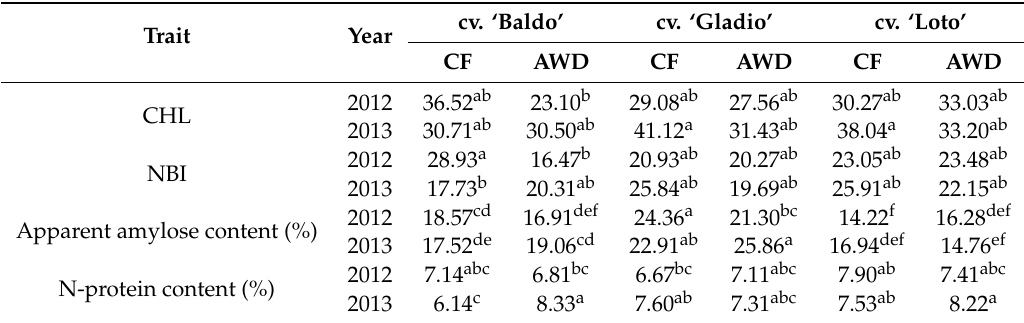
Table 2. Chlorophyll (CHL) and nitrogen balance (NBI) indexes in the flag leaf, apparent amylose and N-protein contents in brown grains of three rice cultivars grown under continuous flooding (CF) or alternate wetting and drying (AWD).